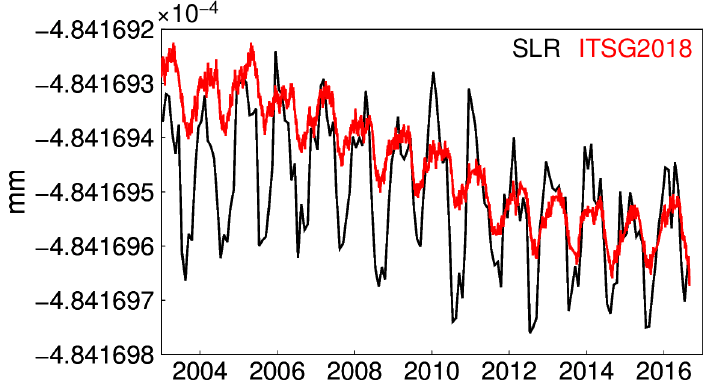
Figure 1. C 20 from satellite laser ranging (SLR) and Institute of Theoretical Geodesy and Satellite Geodesy Gravity Recovery and Climate Experiment (ITSG-Grace2018).